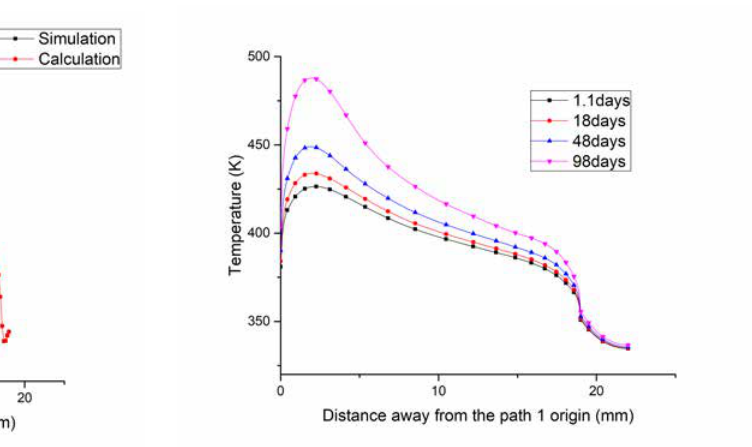
Figure 12: The evolution of temperature along Path